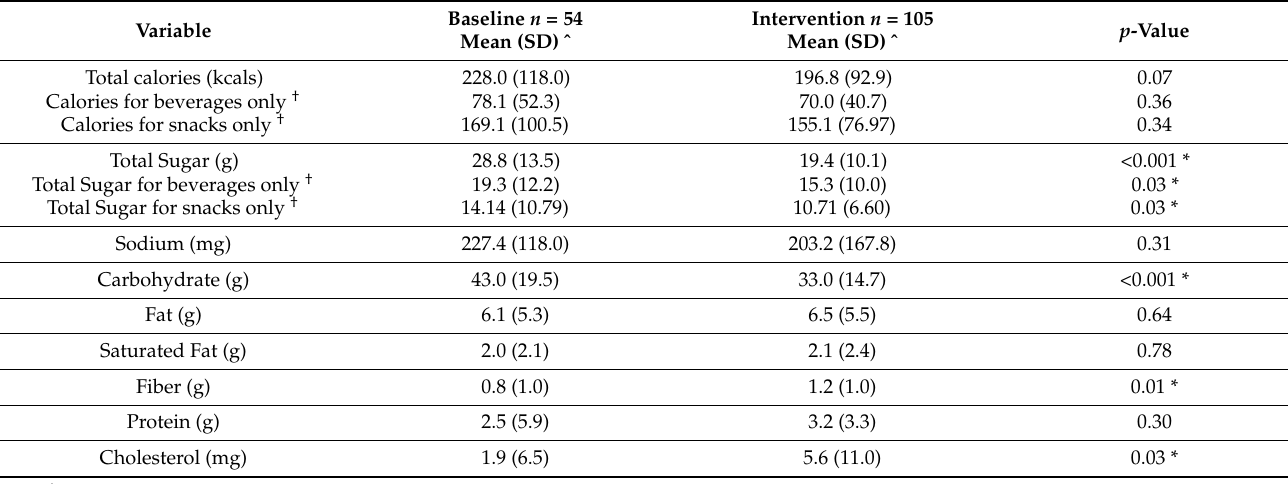
Table 3. Comparisons between nutritional outcomes per game in baseline intervention to postintervention group eliminating games where no snacks/beverages were served.